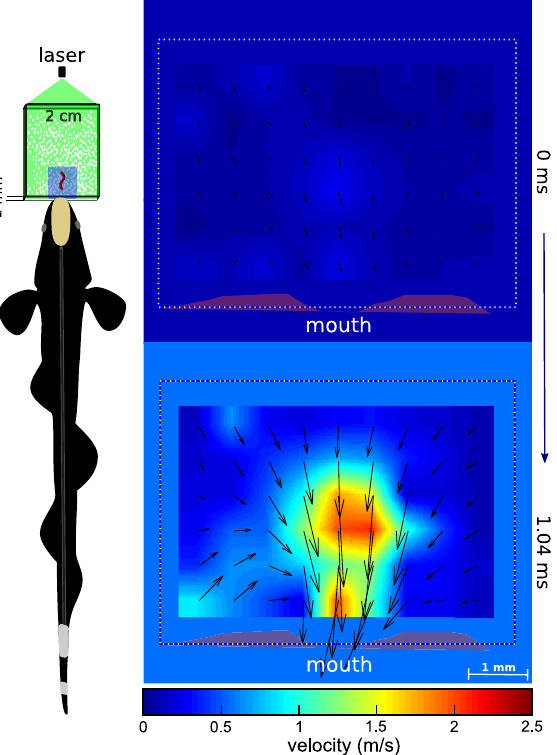
Figure 3. Flow velocity fields using PIV produced by a fish generating suction between two transparent plates, at the beginning (top) and after ~ 1 ms (bottom). Drawing represents the experimental setup. For details see Supplementary information and video S1. This figure was created using MATLAB R2017b (https ://www.mathw orks.com/) and Inkscape 0.92.3 (free available at: https ://inksc